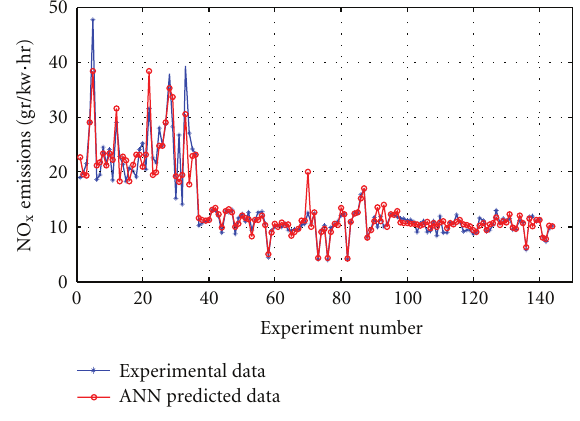
Figure 7: A comparison of the predicted and measured NO x emis- sions for di ff erent operating